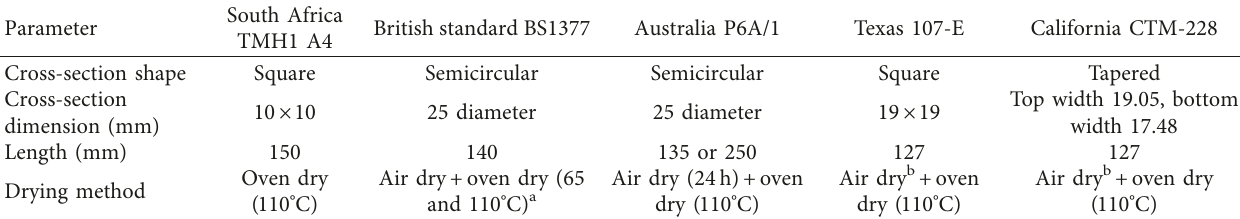
Table 1: Trough designs and drying methods for various BLS testing standards.